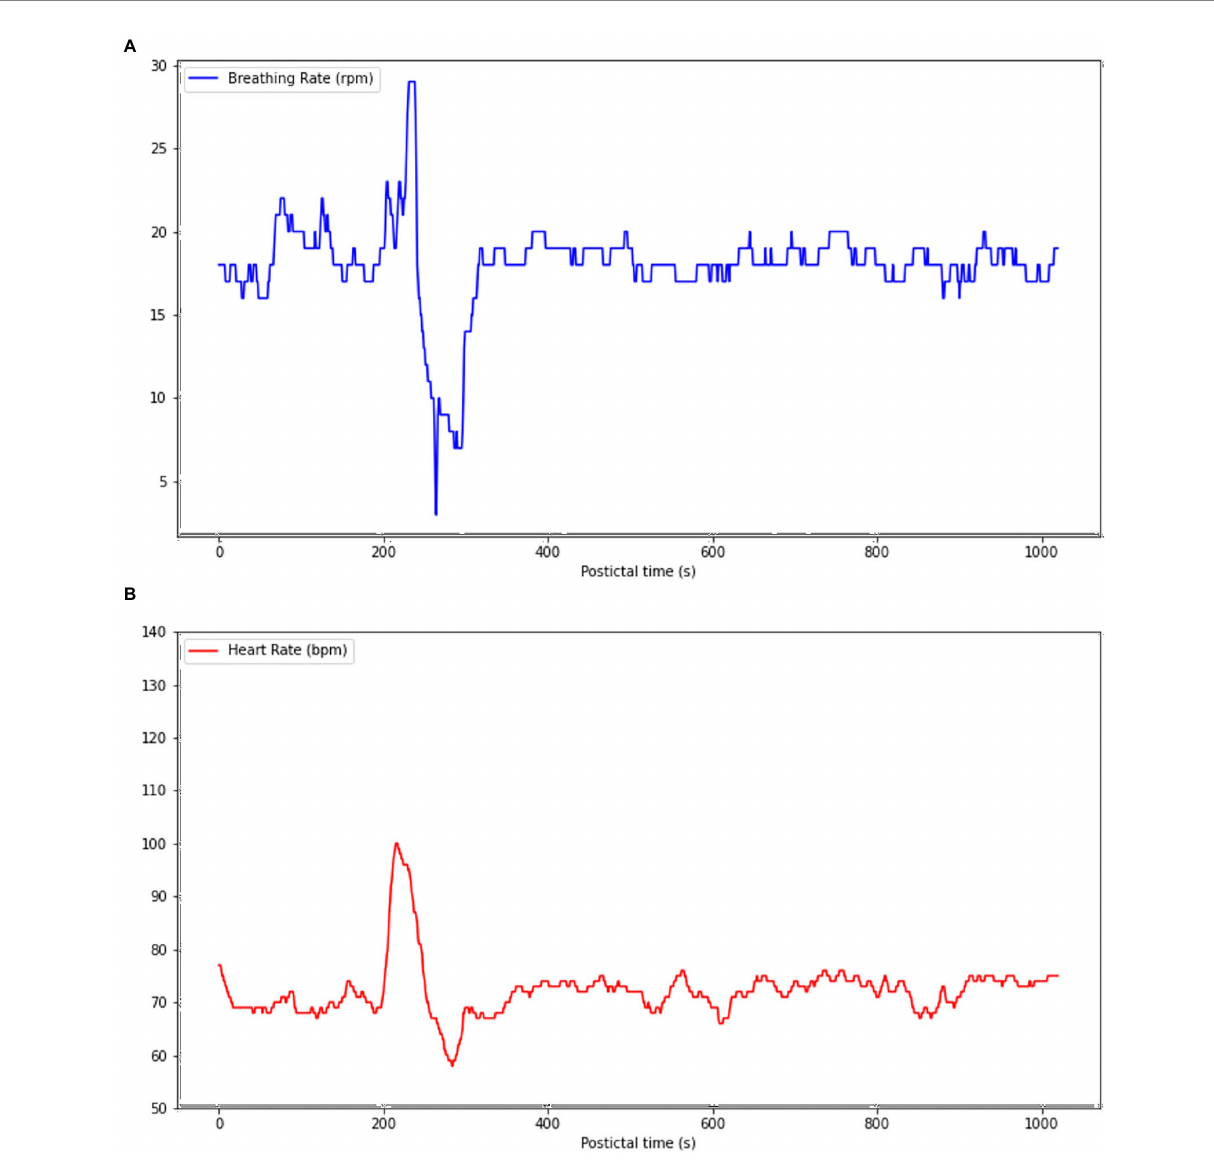
FIGURE 4 Cardiorespiratory functions during the postictal phase following one control’s focal seizure with awareness (FAS). (A) Hyperpnea is present 200 s following seizure termination, but BR rapidly decreases to 6 rpm, resulting in hypopnea 279 s following seizure termination. (B) A tachycardia is present simultaneously to hyperpnea, but HR rapidly decreases simultaneously to BR to a rhythm of 58 bpm 279 s, resulting in abnormal and simultaneous bradycardia and